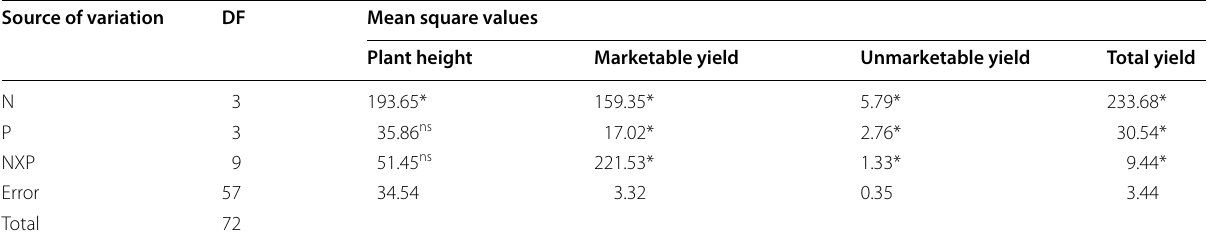
ns non-significant, * and ** significant and highly significant respectively